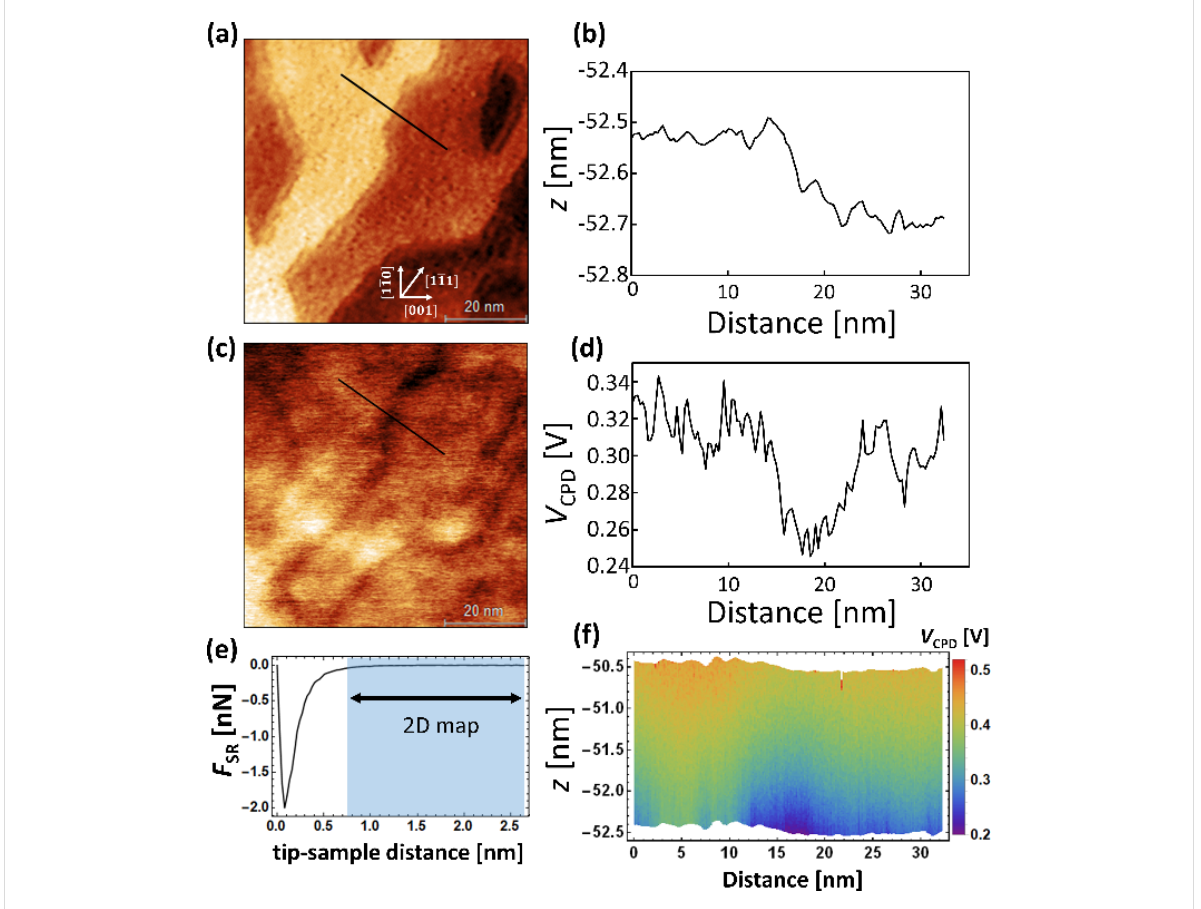
Figure 2: AFM/KPFM images (70 × 70 nm 2 ) of the TiO 2 (110) surface after O 2 exposure. (a) Topographic image and (b) height profile. (c) CPD image and (d) CPD line profile. Line profiles were taken along the black line in (a) and (c). (e) Short-range force curve measured on the terrace. (f) Z – X KPFM data obtained along the black line in (a). The measured z -region corresponds to the blue square in (e). The acquisition parameters: Q = 21134, Δ f = − 150 Hz, V DC = 0 V, f AC = 180 Hz and V AC = 1